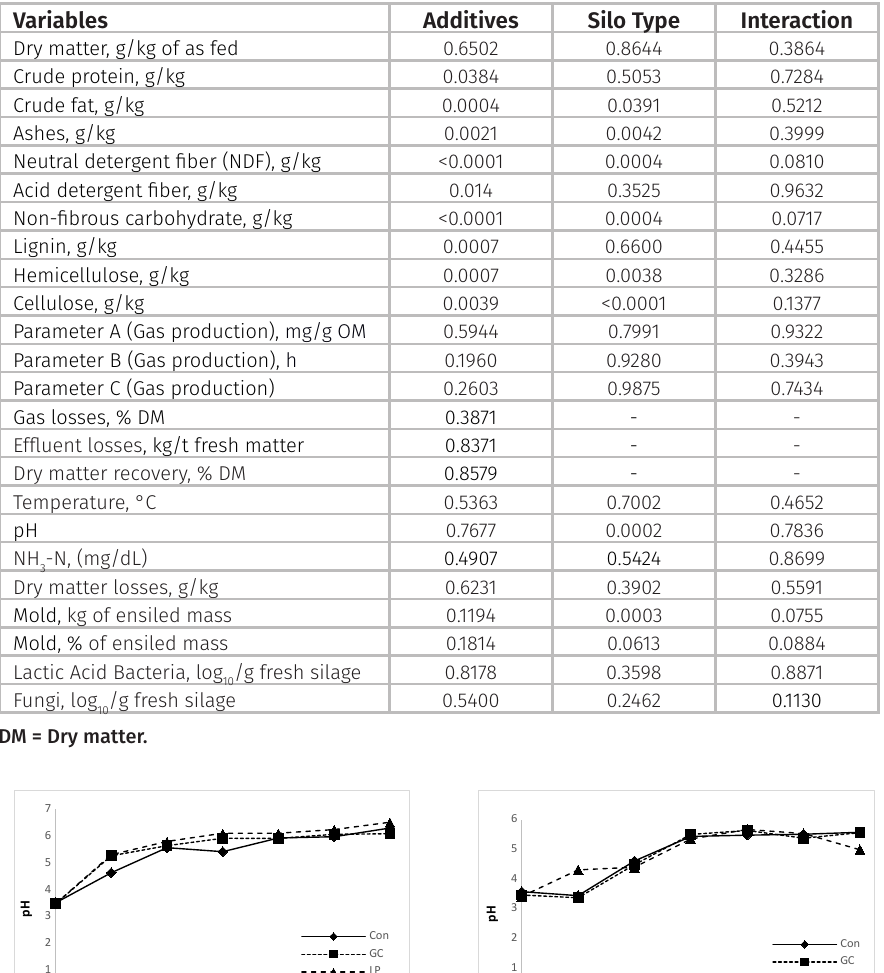
Table I. P-values related to the measured variables analyzed for the effects of the additives, silo type, and interaction between these.